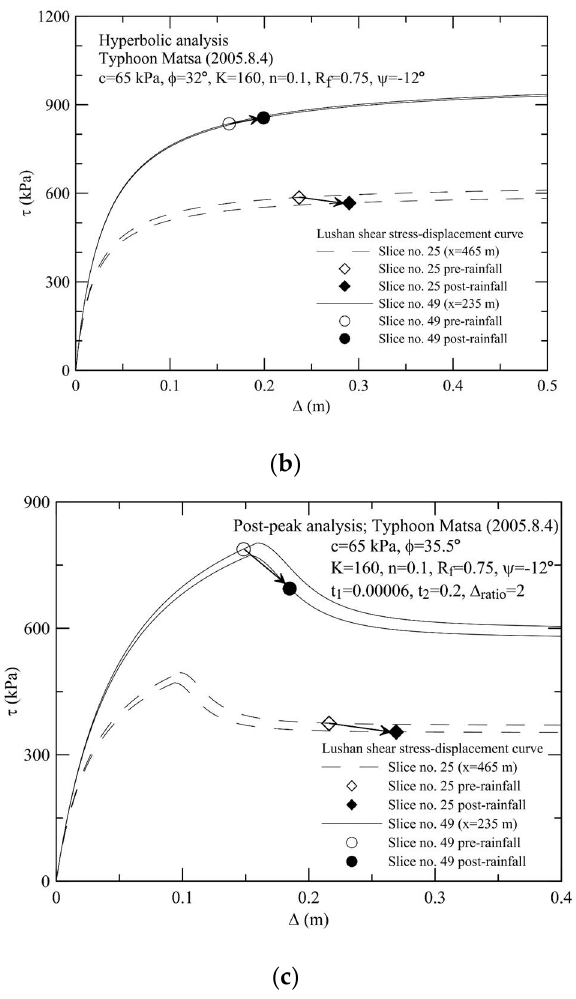
Figure 23. ( a ) Results of detailed stress analyses for slice nos. 25 and 49 of studied slope; ( b ) Variations of pre- and post-rainfall shear stresses obtained ( b ) with and ( c ) without consideration of post-peak softening of soils.